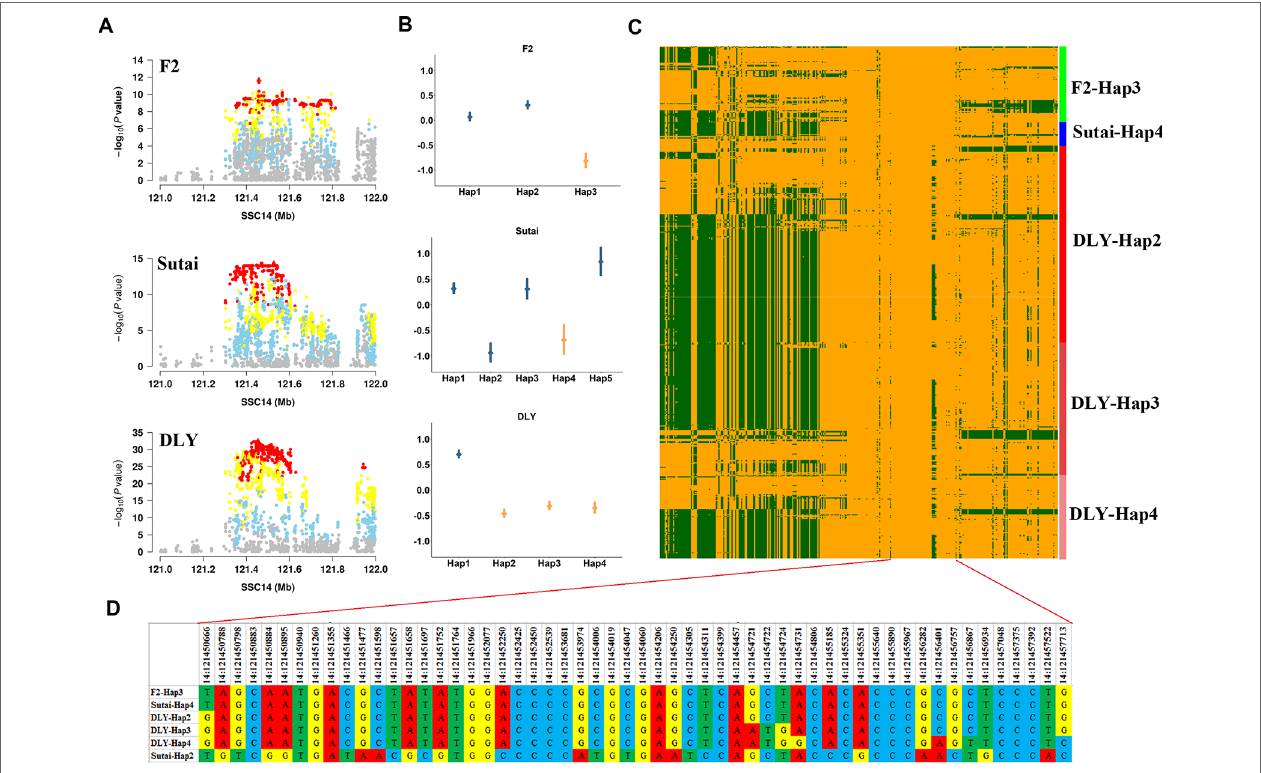
FIGURe 4 | Haplotype analysis of the major QTL for C18:0 on SSC14 in the F 2 , Sutai and DLY populations. (A) The significant regional plots for the SNP that affects the C18:0 content on SSC14 across three populations. (B) Distribution of effects of 41 SNP haplotype centered on the lead SNP for C18:0 identified in DLY pigs. The points represent estimates of the haplotype effects. Vertical bars represented the standard errors of the haplotype effect estimates. Haplotypes that shared the 3.7 kb segment (121,450,788-121,454,457 bp) were highlighted by orange color. (C) Heatmap of haplotypes spans 20kb upstream and downstream (121,434,379-121,473,888 bp) of the lead SNP 14:121,454,019 in individuals that carry Hap3 in F2, Hap4 in Sutai, Hap2, Hap3 and Hap4 in DLY pigs. (D) The detail base pair information of a 7-kb segment than encompassed the 3.7 kb (121,450,788-121,454,457 bp) chromosome segment shared by F 2 -Hap3, Sutai-